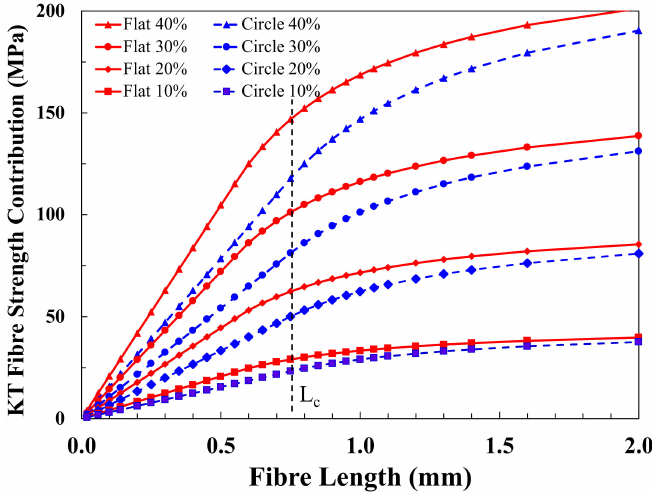
Figure 5. Kelly–Tyson equation prediction of flat and circular fibre strength contribution in unidirec- tional discontinuous GF-PP